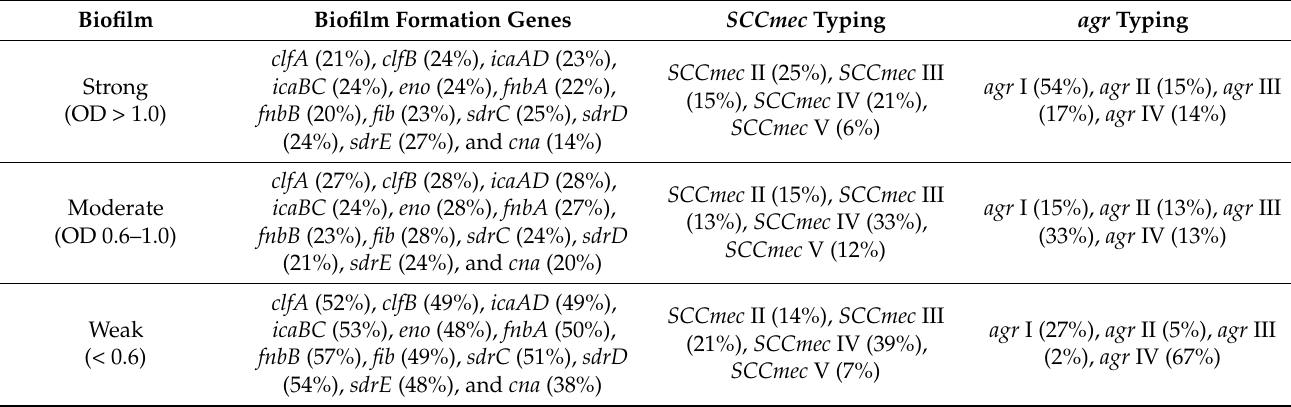
Table 2. Molecular characterization of biofilm-producing MRSA isolates.